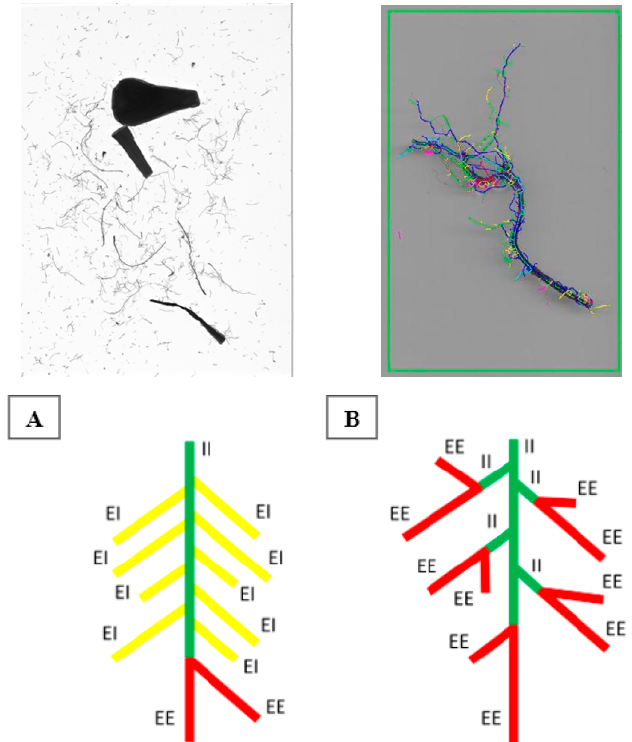
Figure 2. Example scan of sugar beet roots ( left ) and an example for the root analysis with Software WinRHIZO Pro 2020a ( mid ) from treatment NPKCa + m+s and sampling date 10 July. The diagram on the right shows the distinction between extreme branching patterns (( A ) herringbone; ( B ) dichotomous), and the definition of terms used in the analysis, namely exterior-interior (El), interior-interior (II) and exterior-exterior (EE) links; unlabeled links are interior (based on Fitter and Stickland [17]).